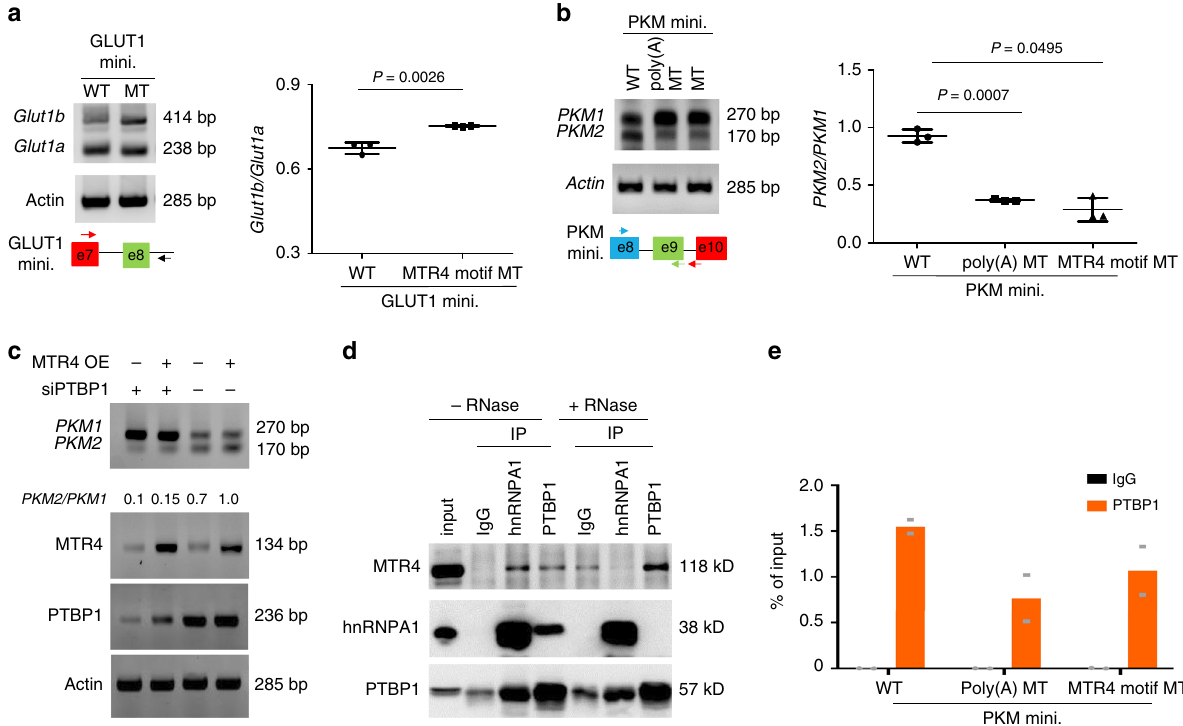
Fig. 5 MTR4 regulates AS of its target pre-mRNA by recruiting PTBP1. a AS of WT and two MTR4 binding motif mutant (MT) including poly(A) MT in GLUT1 minigene in PLC/PRF5 cells. Data are presented as mean value ± s.d. Two-tailed, unpaired t -test. p value is indicated. n = 3 independent experiments. b AS of WT and two MTR4 binding motif mutant (MT) including poly(A) MT in PKM minigene in PLC/PRF5 cells. Data are presented as mean value ± s.d. One-way ANOVA with a Dunnett ’ s multiple comparison test. p value is indicated. n.s., non-signi fi cant. n = 3 independent experiments. c Impact of PTBP1 knockdown on AS of PKM minigene in PLC/PRF/5 cells with or without MTR4 overexpression. The levels of PKM1 and PKM2